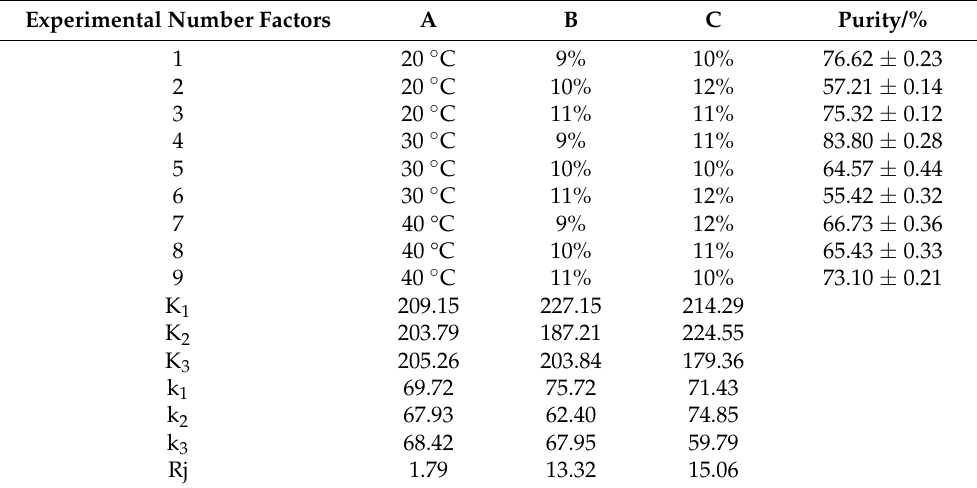
Table 6. Orthogonal test